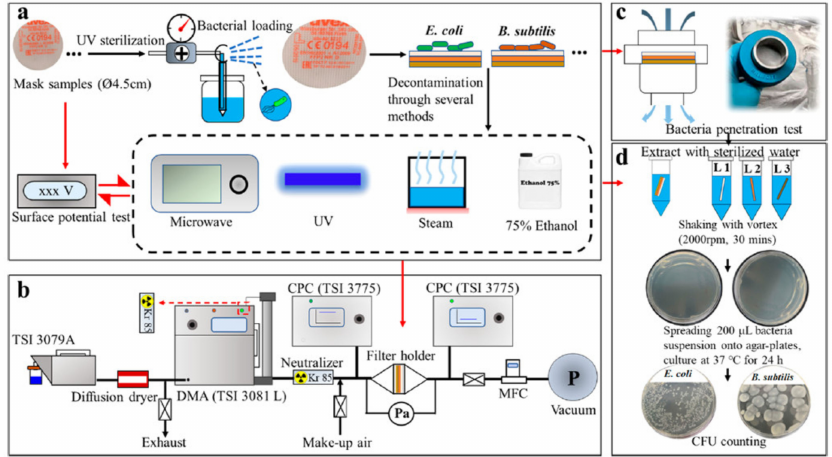
Figure 4. A schematic showing ( a ) various setups for decontamination and regeneration, ( b ) setup for particle filtration efficiency test post decontamination, ( c ) bacteria penetration test setup, and ( d ) colony unit counting post bacteria filtration. Reprinted with permission from [136]. Copyright © 2020 American Chemical